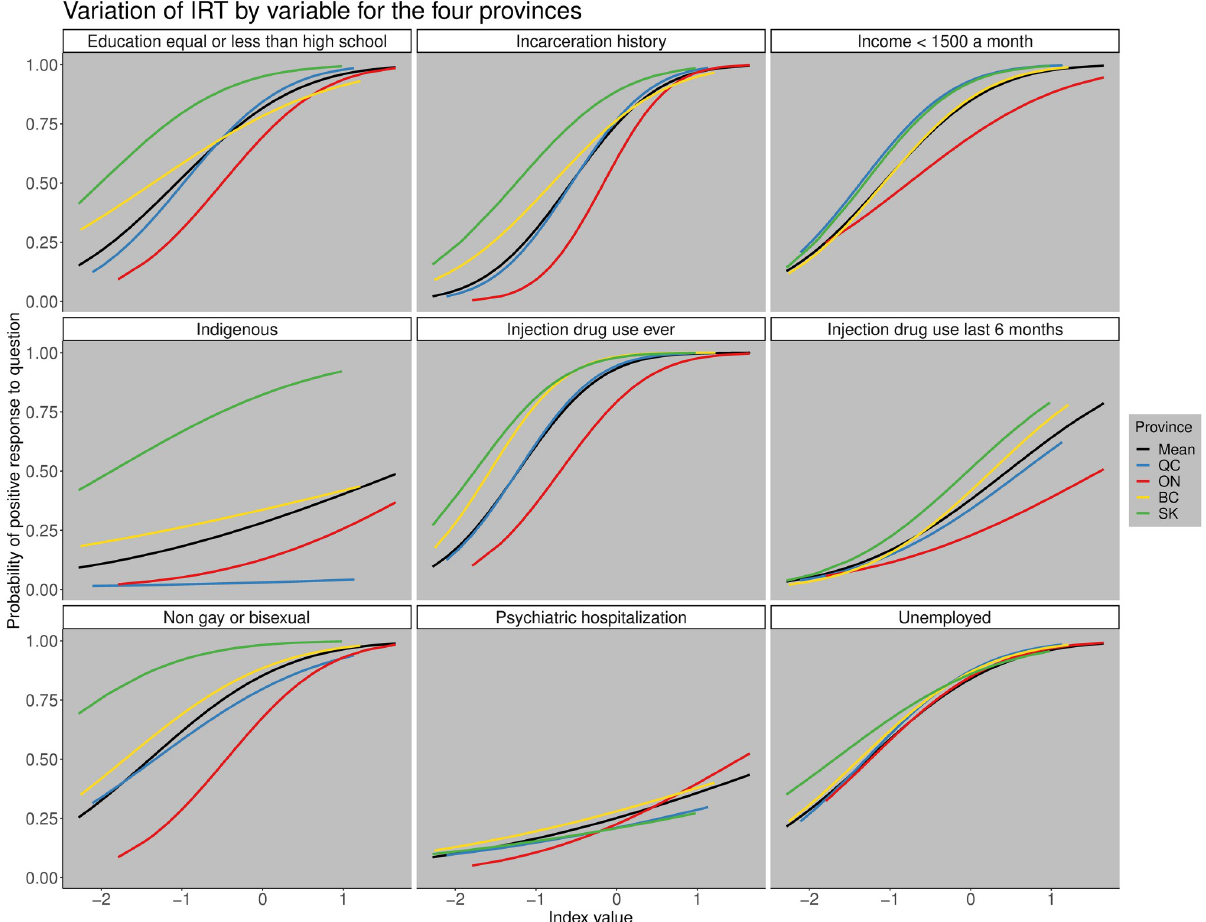
Fig 2. Variation of IRT by variable for the four provinces. Variation of the item characteristic curves for each province by variable. The black line represents the mean value for all the indices, the blue line for Quebec, red line for Ontario, yellow line for British Columbia, and the green line for Saskatchewan. The x − axis shows the value of the estimated deprivation index and the y − axis the probability of responding positively to the question.